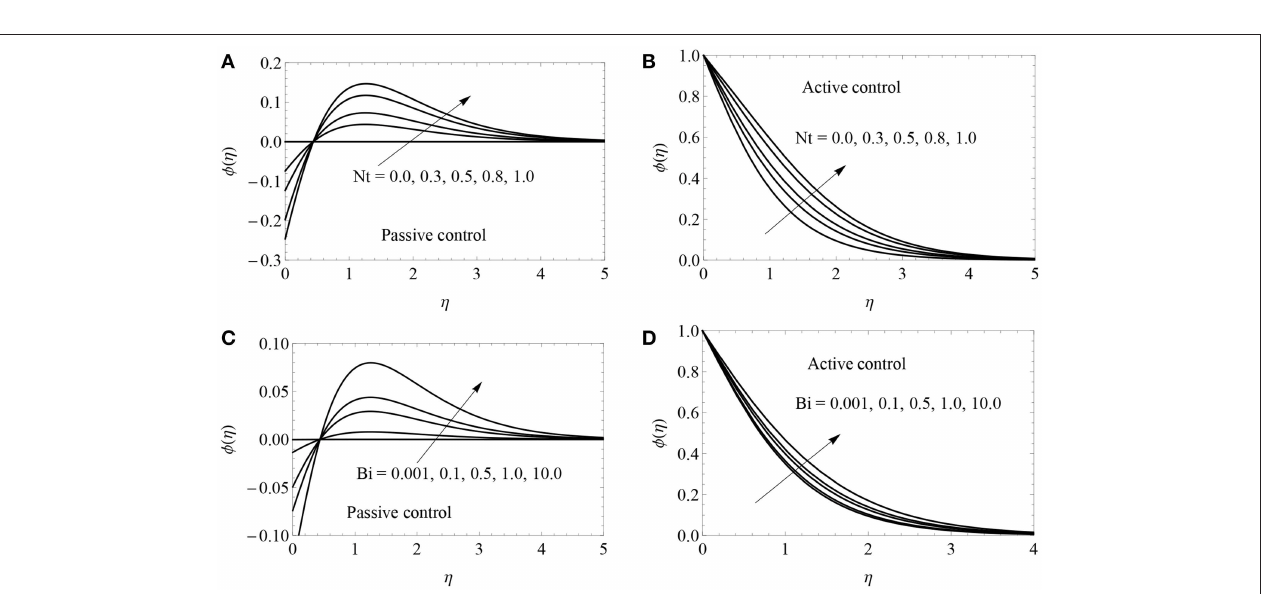
0.1, c 0.5, Nb 0.5 and = = =